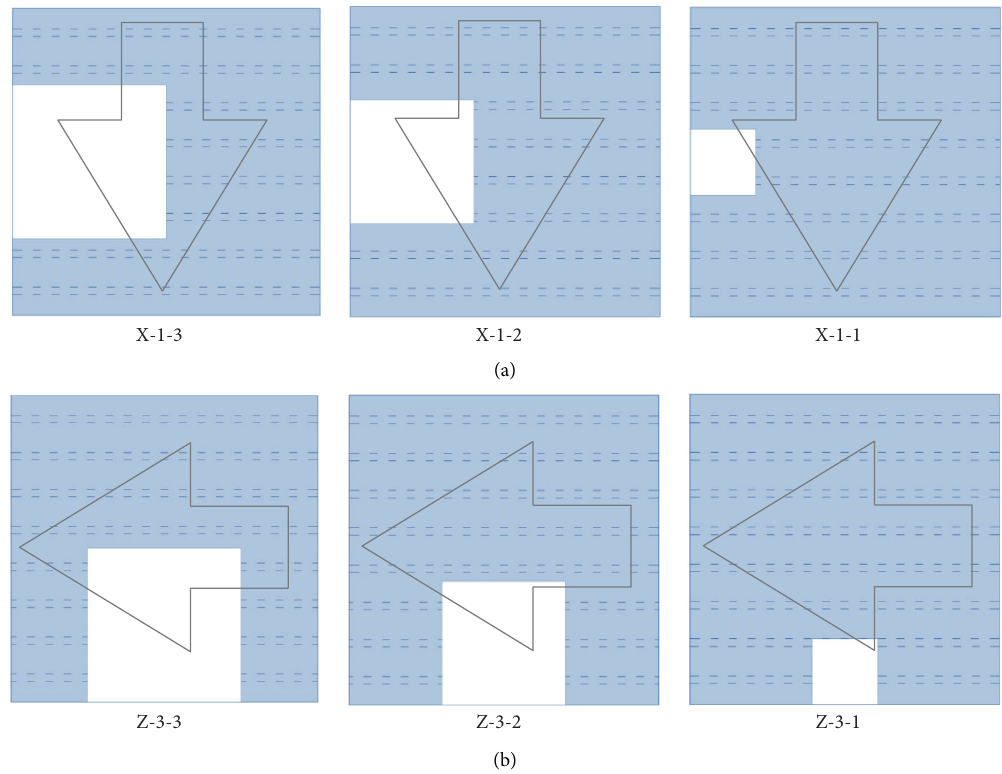
Figure 18: Opening location and corresponding model name for loading in X and Z directions. (a) Opening location and corresponding model name for loading in X direction. (b) Opening location and corresponding model name for loading in Z direction.